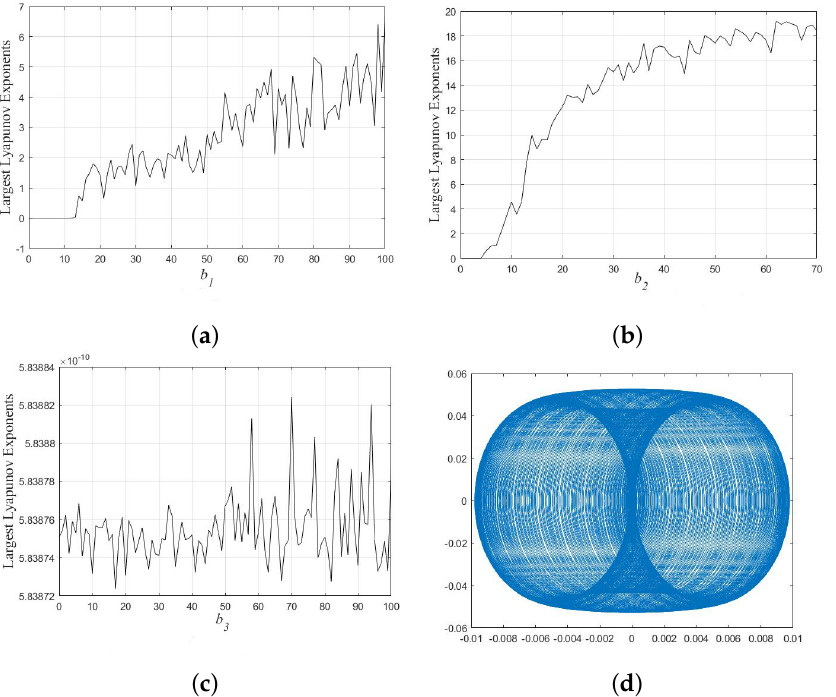
Figure 7. System (18): ( a ) largest Lyapunov Exponents for b 1 ; ( b ) largest Lyapunov Exponents for b 2 ; ( c ) largest Lyapunov Exponents for b 3 ; ( d ) Phase portrait, when b 1 = − 0.983, b 2 = − 0.33, b 3 = − 0.987, b 4 = − 0.9, R 2 ( ξ ) = cos ( 10 ξ )